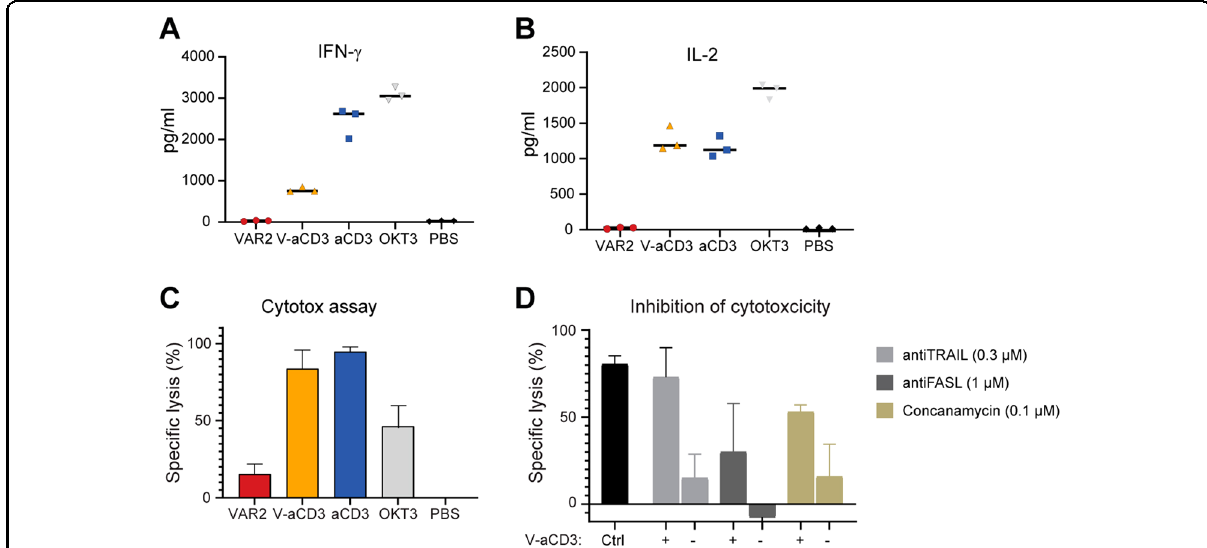
Fig. 4 V-aCD3 mediated cytokine release and reduced cytotoxcicity by anti-FASL and concanamycin A. A IFN-gamma and B IL-2 cytokine release induced by V-aCD3 and controls. C Levels of tumor cell lysis (and cytokine levels) were measured after cultivation of PBMCs and UM-UC-3, effector: target (5:1) with maximum killing doses of V-aCD3 (100 nM) and controls. The data shown is three replicate measurements from one representative of three experiments using PBMC donors. Error bars represent standard error of the mean (SEM) D the effect of V-aCD3 activated PBMC when inhibited with anti-TRAIL, anti-FASL, and concanamycin A. PBMC was preincubated with inhibitors before applied to target cells in the presence of V-aCD3. V-aCD3 mediated killing in the presence of PBMC and inhibitors was determined by luminescence arising from oxidation of D-luciferin by luciferase expressed by viable cancer. Error bars represent SEM from triplicate